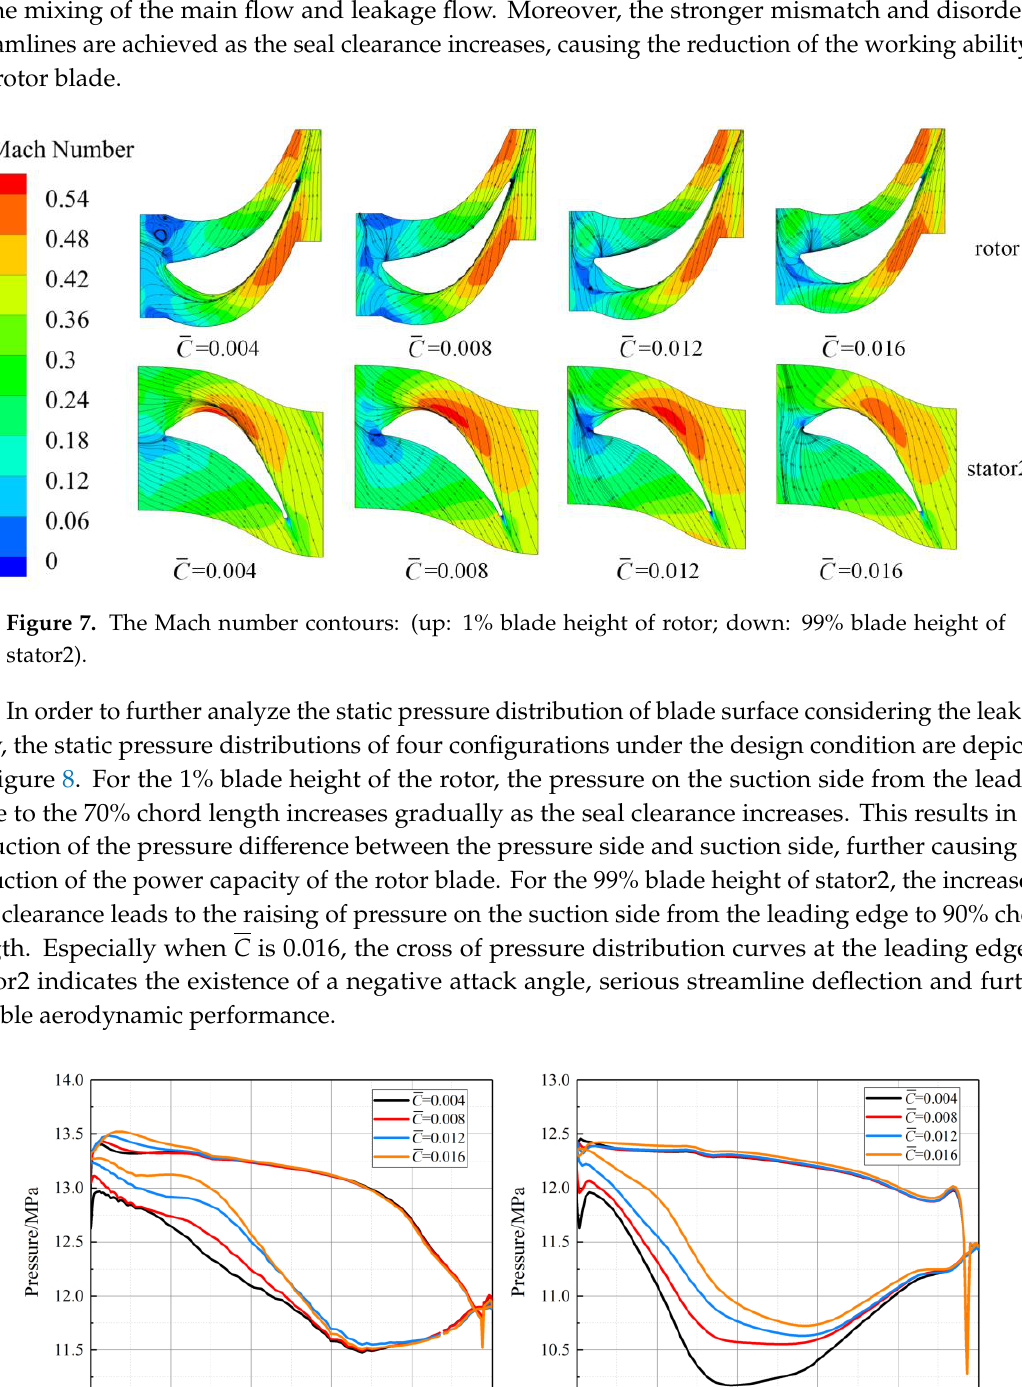
Figure 6. The static entropy contours of the meridional planes.